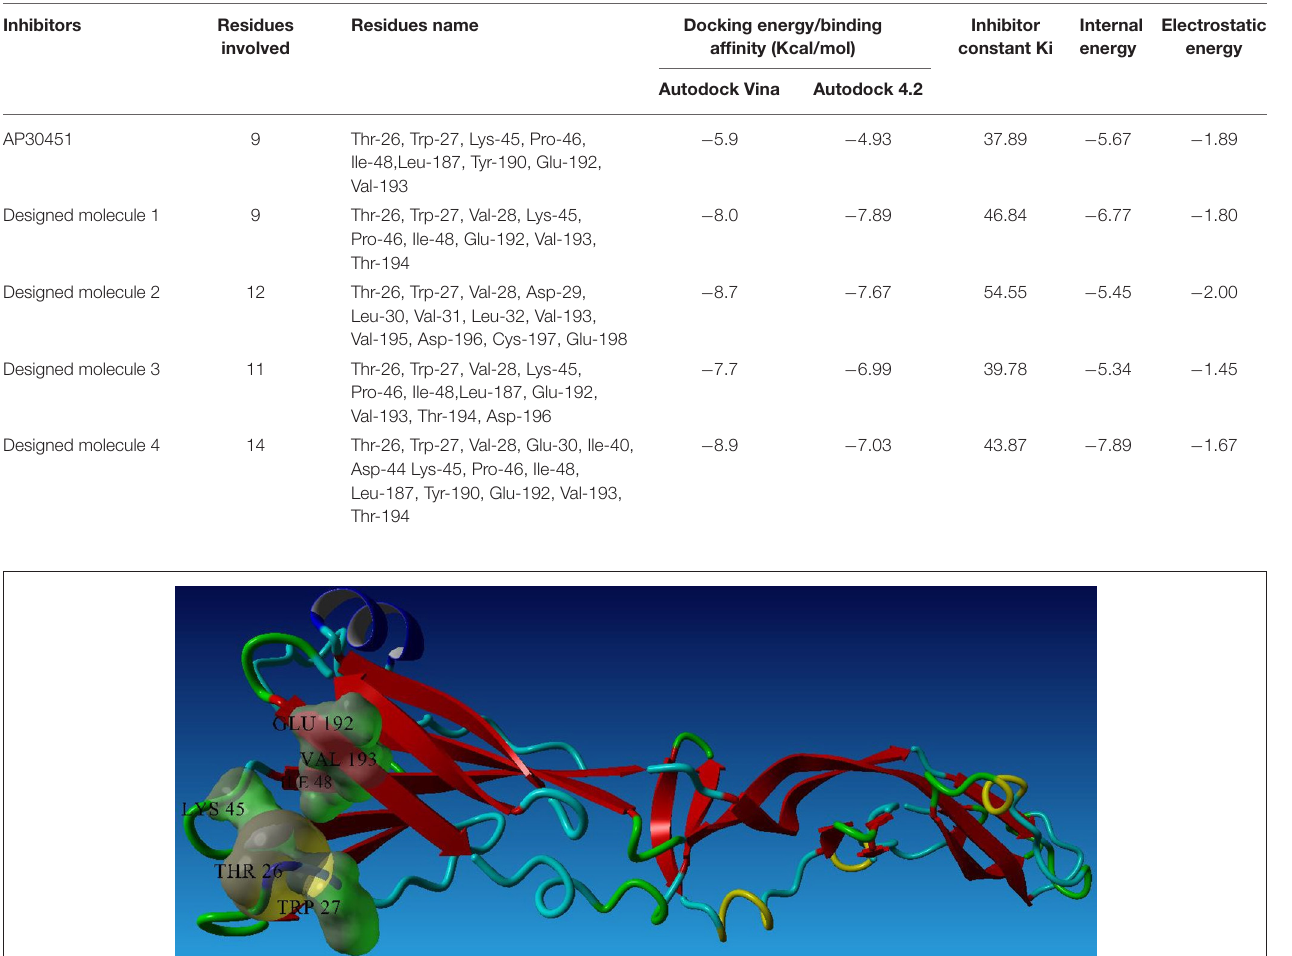
TABLE 4 | Docking result of Designed inhibitors.